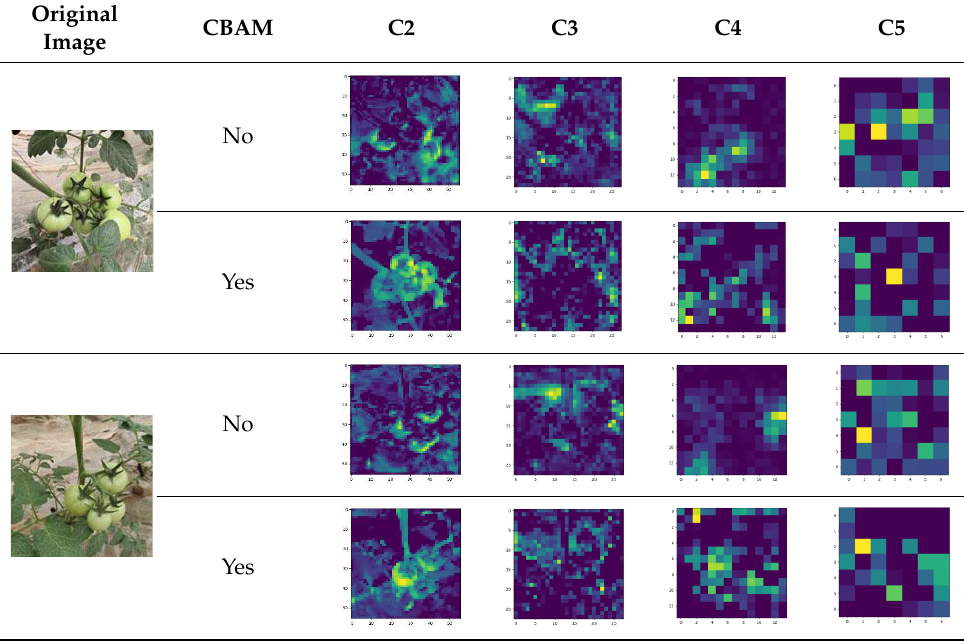
Table 3. Output feature maps of different residual body.